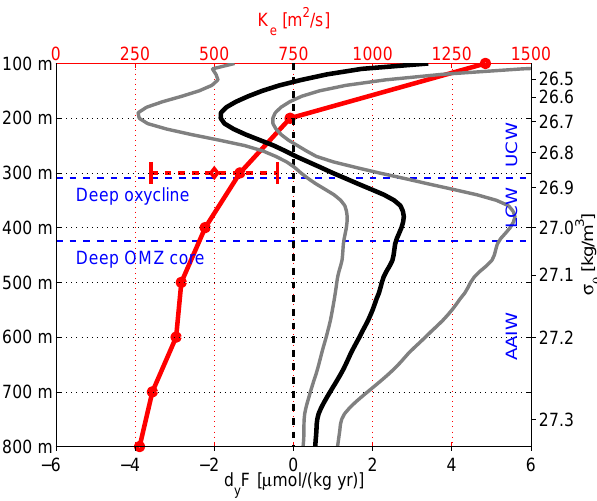
Figure 14. Eddy diffusivity as estimated from moored and ship- board observations (red circles, red line, upper axis) and from the tracer release experiment (red diamond with error bar, upper axis) as function of depth (left axis) or potential density (right axis). Also shown is the mean isopycnal meridional eddy-driven oxygen supply (black line, lower axis) for the open ocean ETNA OMZ with error levels (grey lines, lower axis) that were calculated from both the error of the curvature of the meridional oxygen distribution (95% confidence) and the error of the eddy diffusivity (factor of 2 as- sumed). Blue dashed lines mark the depths of the deep oxycline and of the core of the deep OMZ that separate layers of upper and lower CW, and